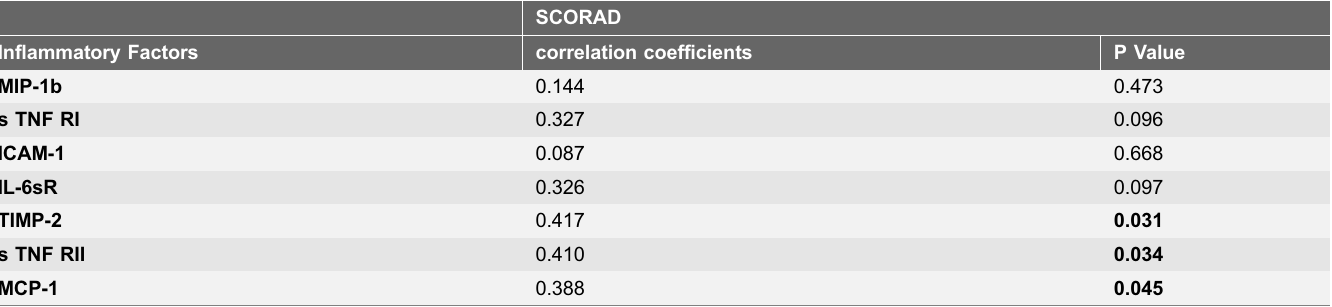
Table 4. Correlation analysis between Clinical parameters and 7 Factors in childhood